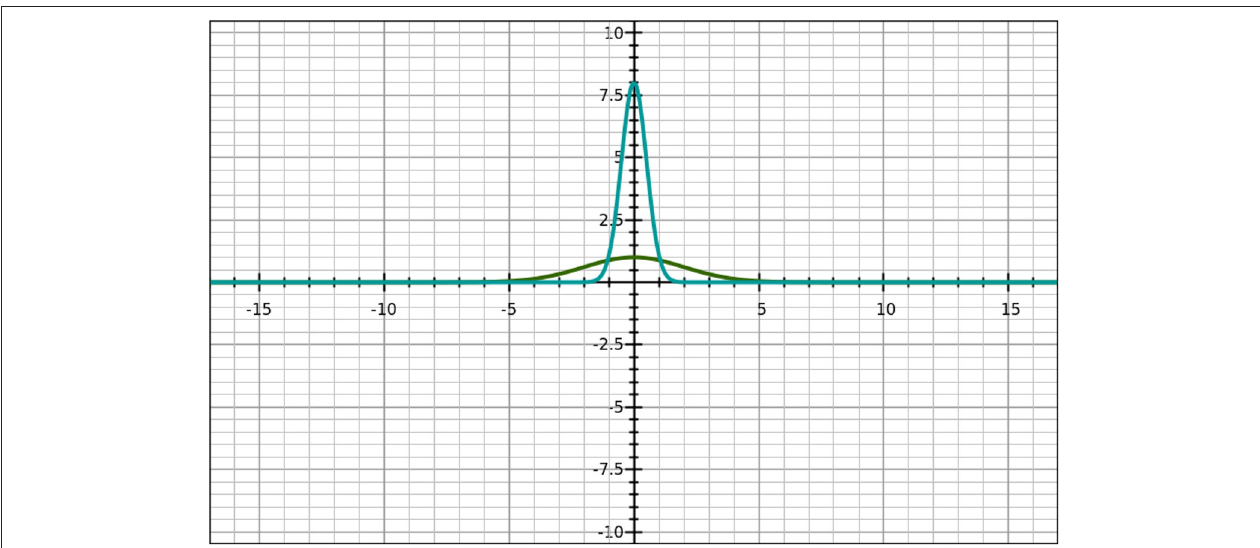
FIGURE 1 | As a notional example, the wide Gaussian is Fourier transformed to the narrow one; the Standard deviation for the latter one is 0.33, that for the wide one about 5.0; the two multiplied together is > 1/2.